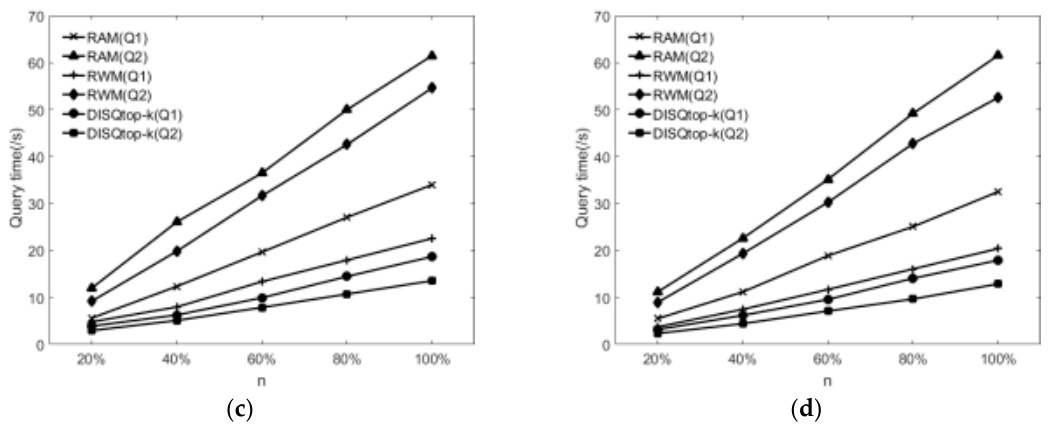
Figure 9. Comparison of query time for different algorithms. ( a ) Comparison of query time in DataBase systems and Logic Programming (DBLP); ( b ) Comparison of query time in Wordnet; ( c ) Comparison of query time in Youtube ( d ) Comparison of query time in Dbpedia.